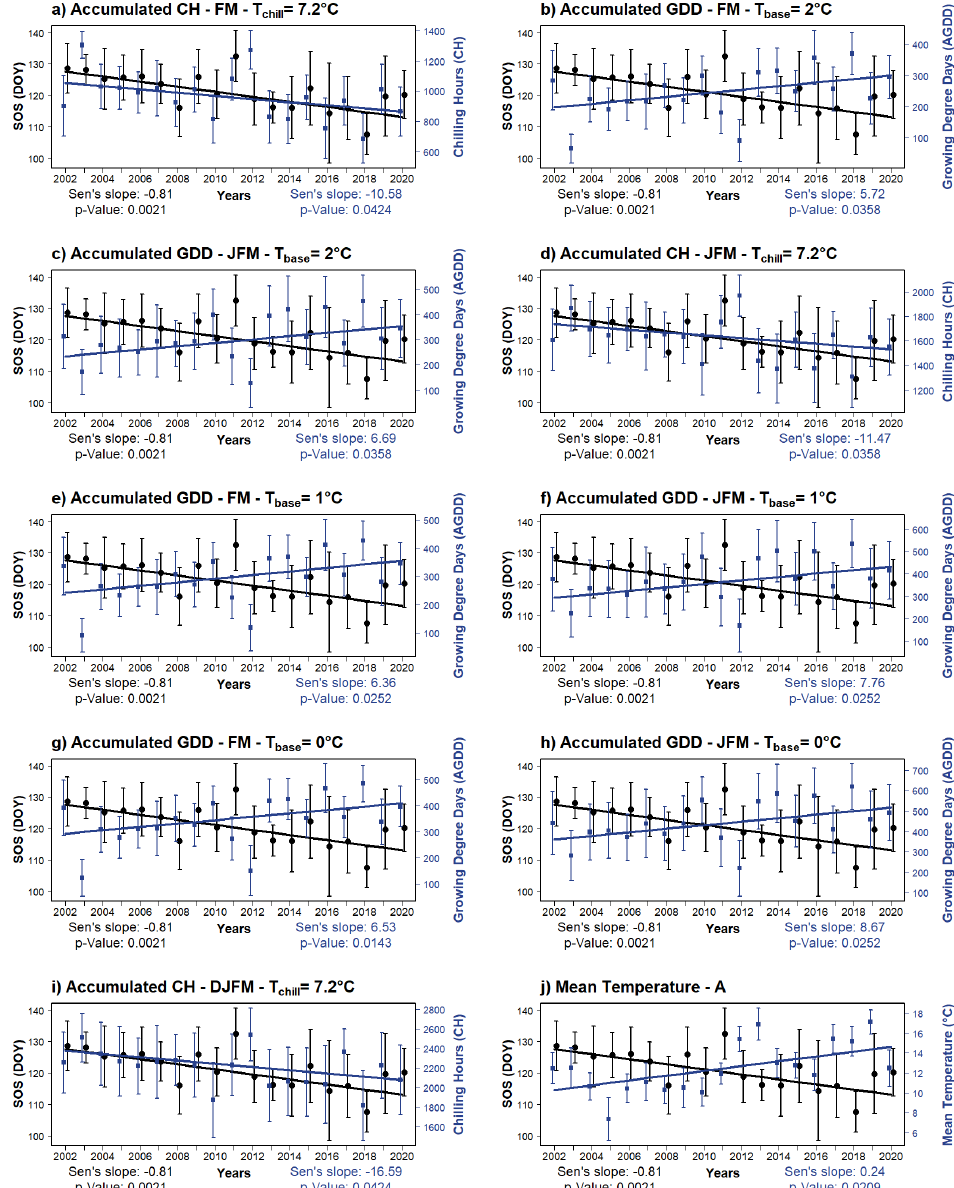
Figure 12. Superimposed plots of the mean SOS trend and significantly correlated climate varia- ables/intervals over the study period (2002–2020). CH = chill hours; GDD = growing degree days; bles/intervals over the study period (2002 – 2020). CH = chill hours; GDD = growing degree days; D, J, F, M, and A stand for December, January, February, March, and April, respectively.